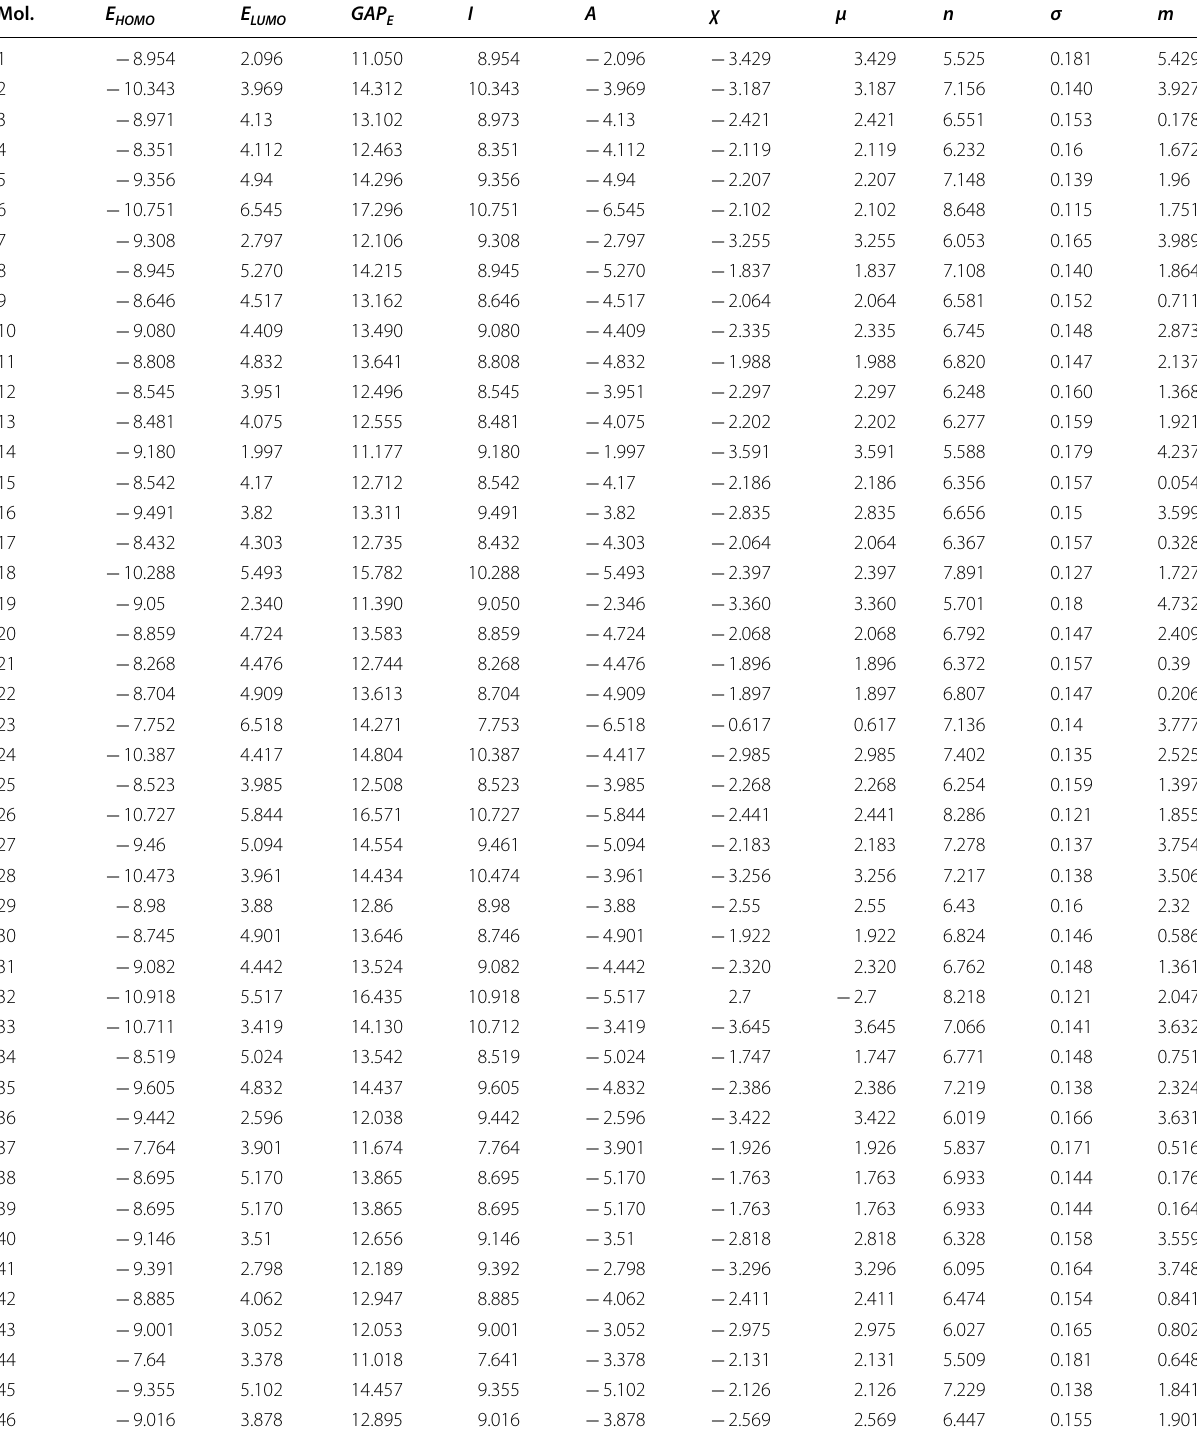
Table 6 Chemical reactivity descriptors calculated